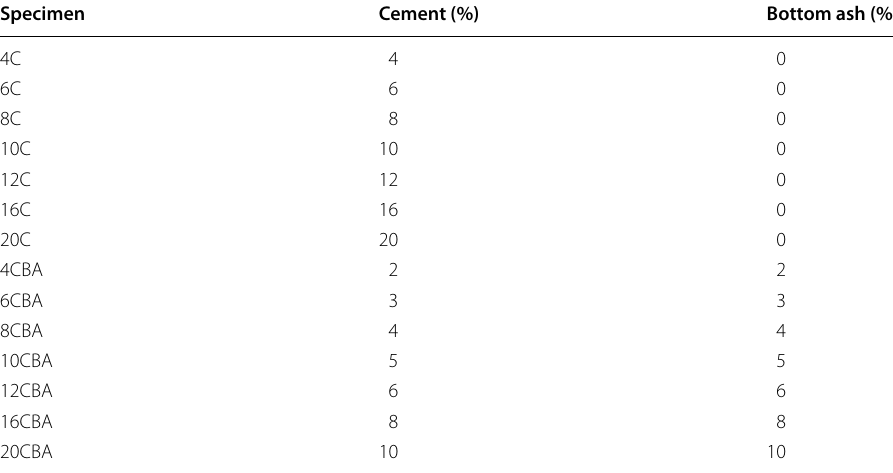
Table 5 Mix proportion of different specimens (%age by weight) Specimen Cement (%) Bottom ash